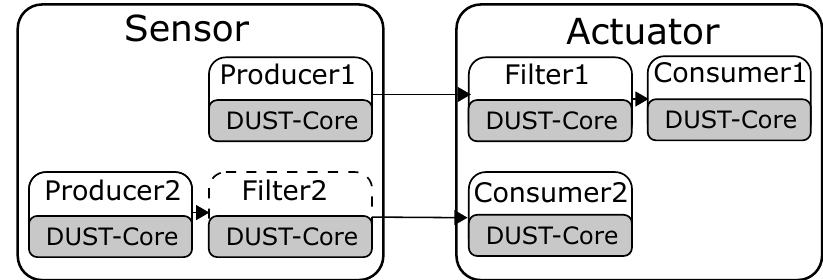
Figure 6. The streaming configuration from sensor to actuator. The filters can be placed on the sensor or on the